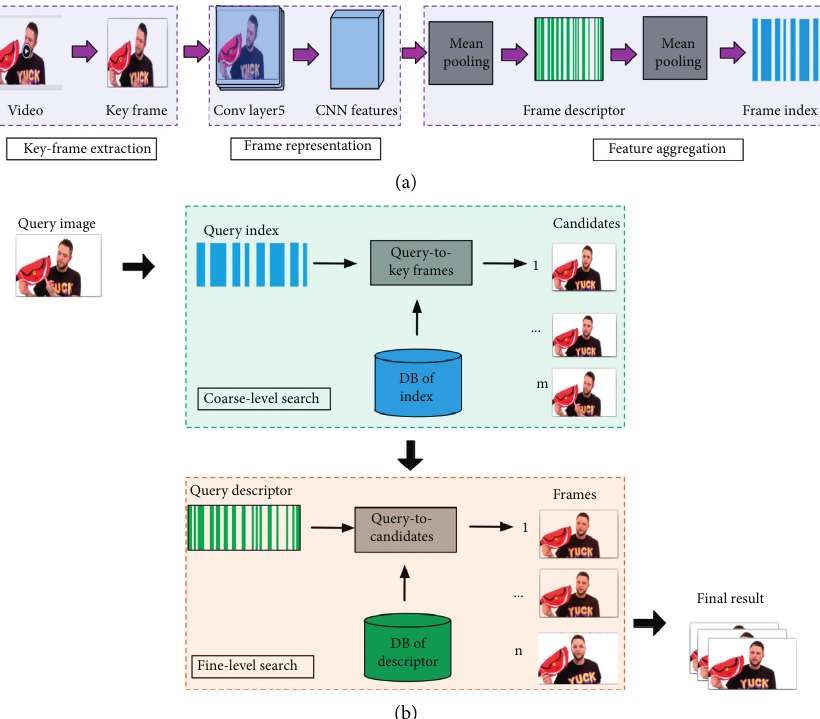
Figure 2: Block diagram of our proposed retrieval approach which searches video databases by images. (a) The process of indexing and extracting the descriptors for an image. (b) The process of coarse-to-fine